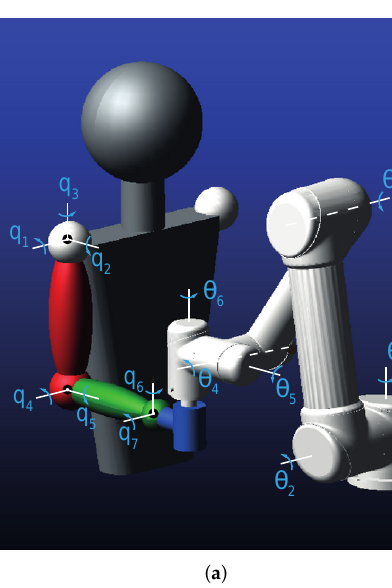
Figure 1. ( a ) Kinematic chain of the human–robot system; ( b ) ergonomic handle attached to the